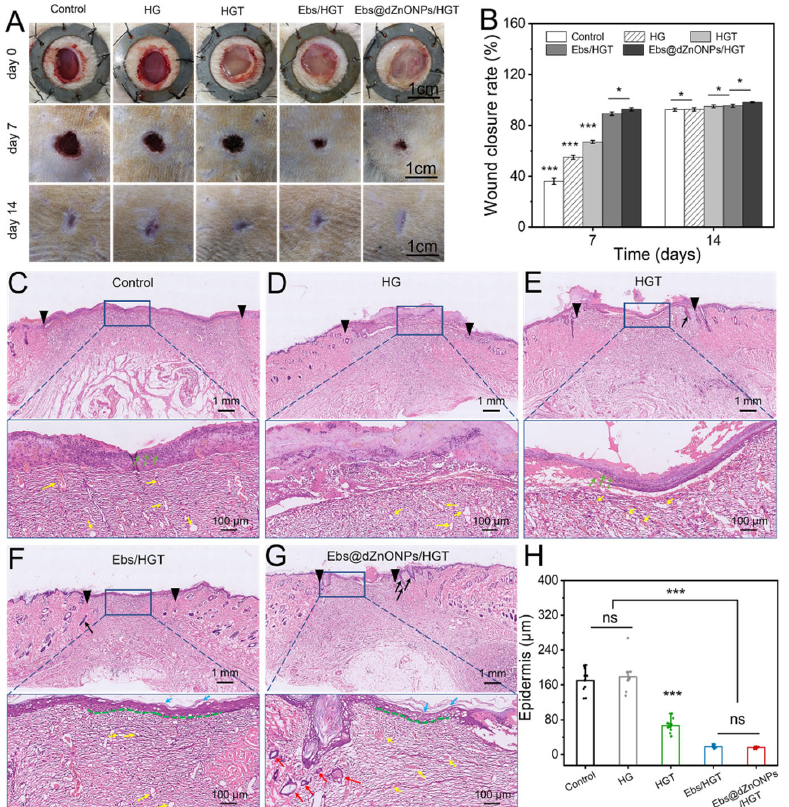
Figure 7. In vivo experiments of hydrogels. ( A ) Macroscopic images of wound healing on days 0, 7, and 14 of treatment; ( B ) Wound closure rates on days 7 and 14 of treatment. Results of HE staining of the new skin after 7 days of treatment: ( C ) Blank group, ( D ) HG hydrogel group, ( E ) HGT hydrogel group, ( F ) Ebs/HGT hydrogel group, ( G ) Ebs@dZnONPs/HGT hydrogel group, ( H ) Quantitative analysis of epidermal layer thickness. Data are presented as mean ± standard ( n = 3), * means p < 0.05, *** means p < 0.001.